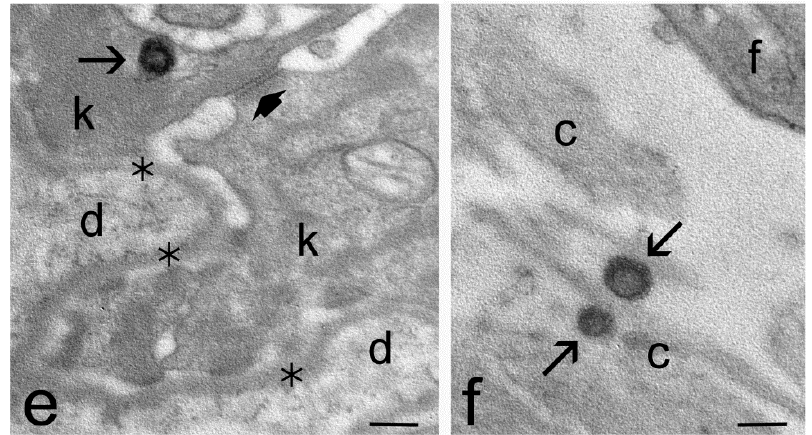
Figure 4. TEM micrographs of ET in the skin. ( a ) An ET (arrow) occurs in the intracellular space of the stratum corneum. ( b ) An ET (arrows) has been internalized in a corneocyte. In the high-magnification micrograph, the dark rim and the weakly electron-dense core of the ET (arrow) are clearly visible. ( c ) An ET (arrow) in the cytoplasm of a keratinocyte belonging to the stratum granulosum. ( d ) ET (arrows) make contact with mitochondria (m) and smooth endoplasmic reticulum cisternae (thin arrow in the inset). ( e ) An ET in the cytoplasm of a keratinocyte (k) of the stratum basale. Note the well-preserved desmosome (arrowhead) and the basal lamina (asterisks) connecting keratinocytes (k) to the dermis (d). ( f ) Two ET (arrows) in the extracellular matrix of the upper papillary dermis; c, collagen bundles; f, fibroblast. Bars: 200 nm ( a , c – f , inset b ); 1 µm ( b ). Many TET-1 were found after 1 h both in the intercellular space and inside the cells